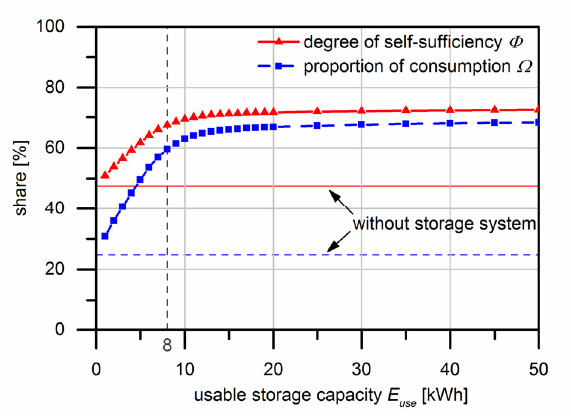
Figure 8. Degree of self-sufficiency and proportion of consumption in dependence of usable storage